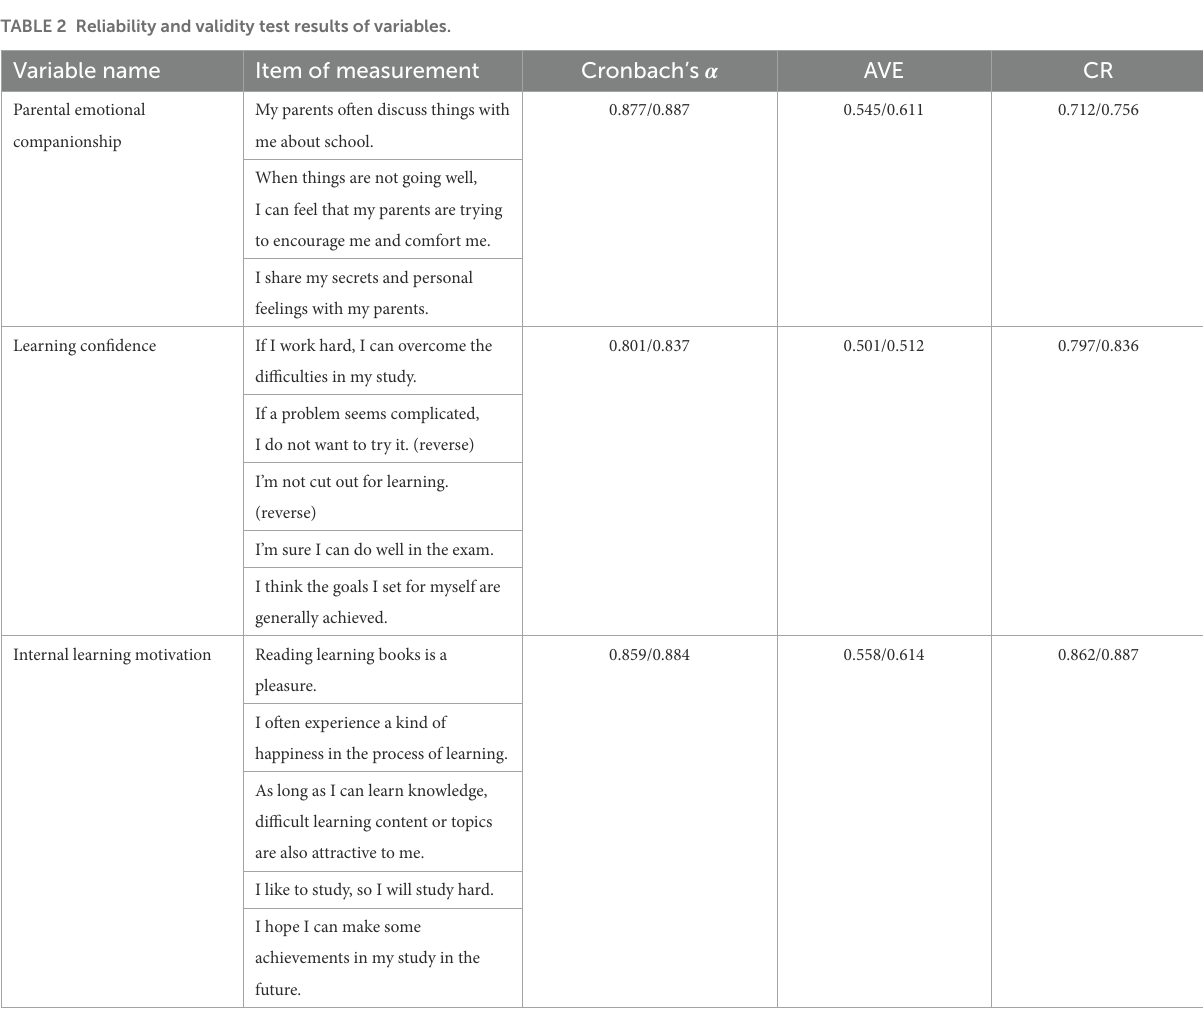
TABLE 2 Reliability and validity test results of